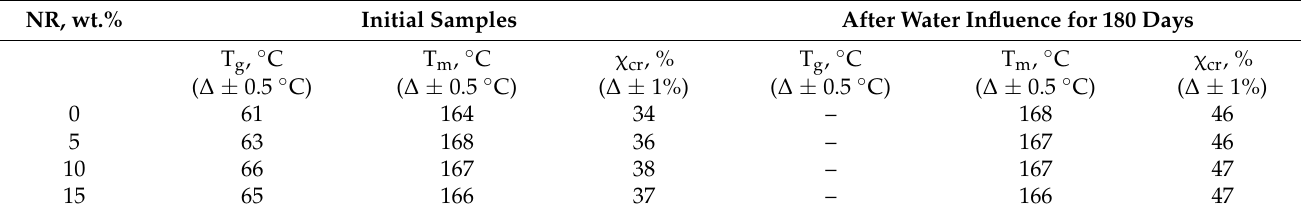
Table 2. Thermophysical characteristics of PLA/NR nonwoven fiber samples: initially and after 180 days of water degradation. NR,